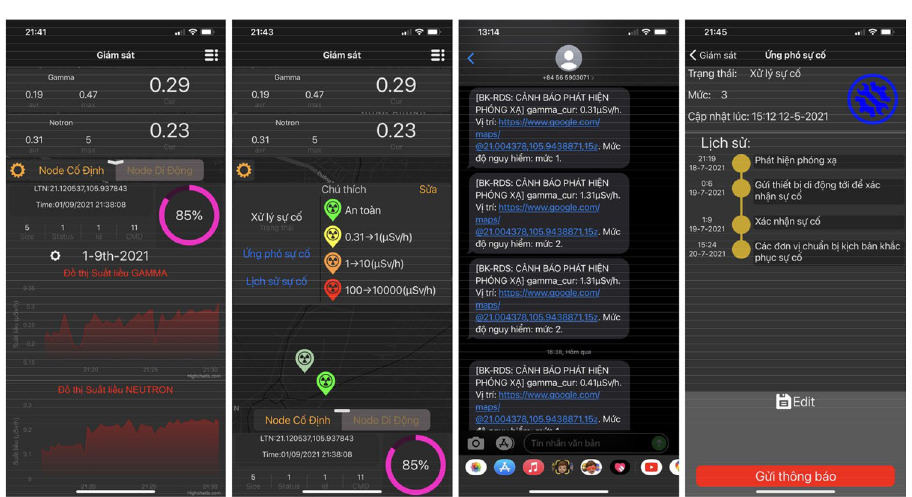
Figure 14. User application on a smartphone, customized for Vietnamese